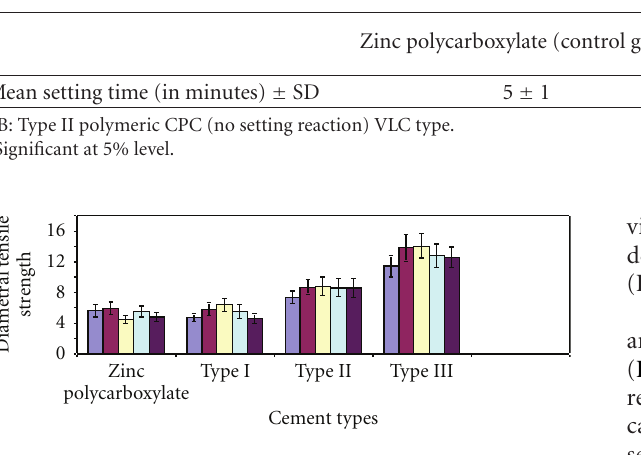
(67.15 MPa) and remained nearly constant to the end of the eighth week (67.12